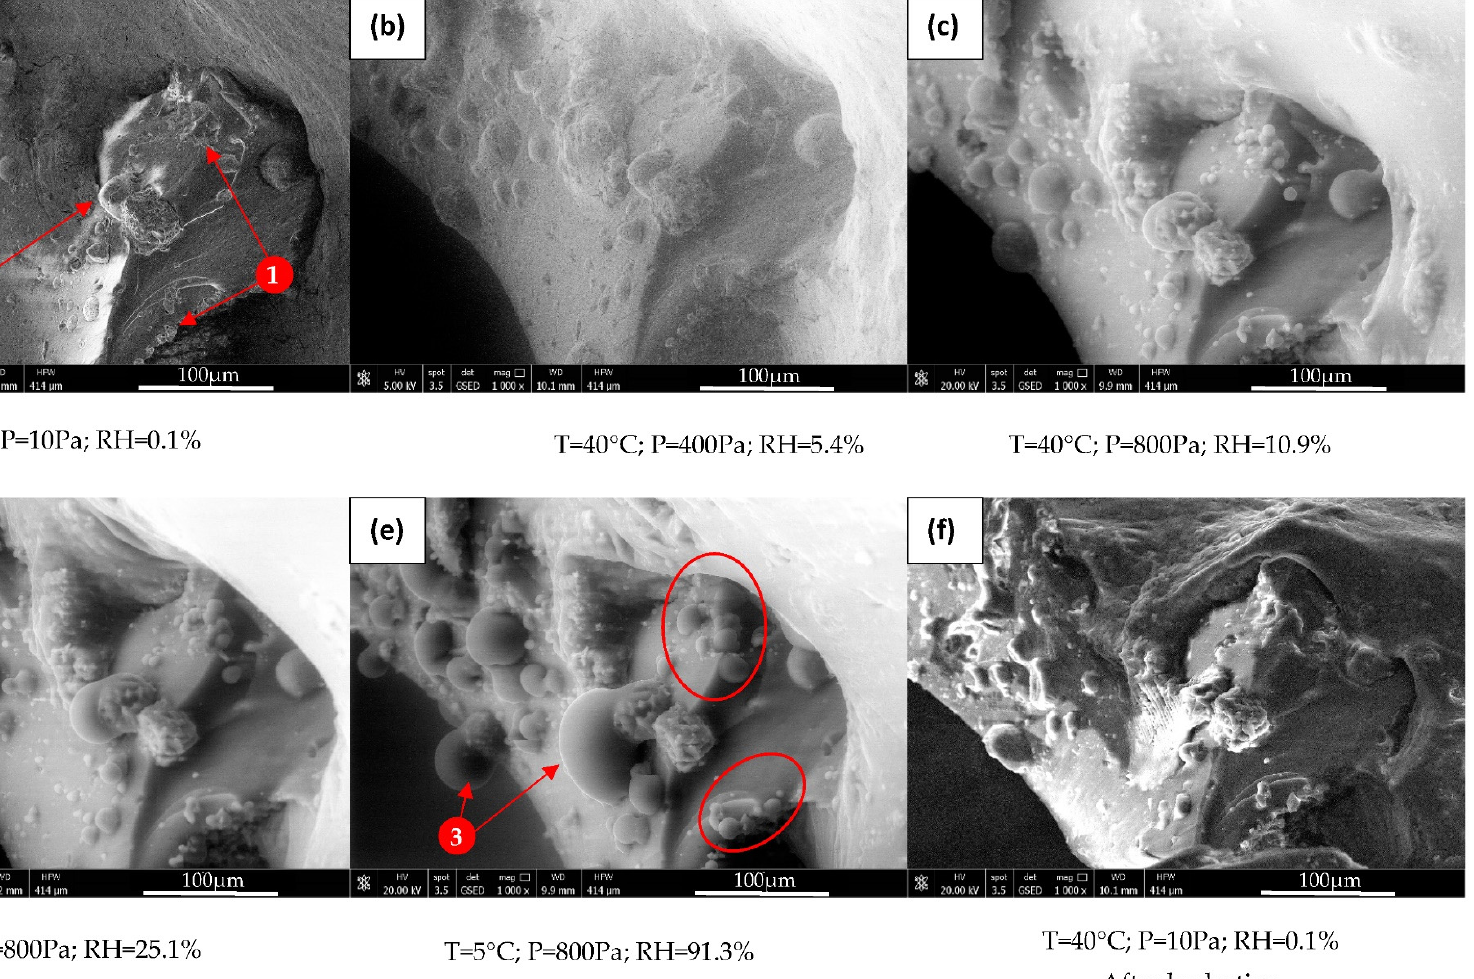
Figure 6. Environmental SEM analysis on LiCl-PDMS foam under varying temperature and water vapor pressure in the ranges of 5–40 °C and 10–800 Pa, respec- tively.